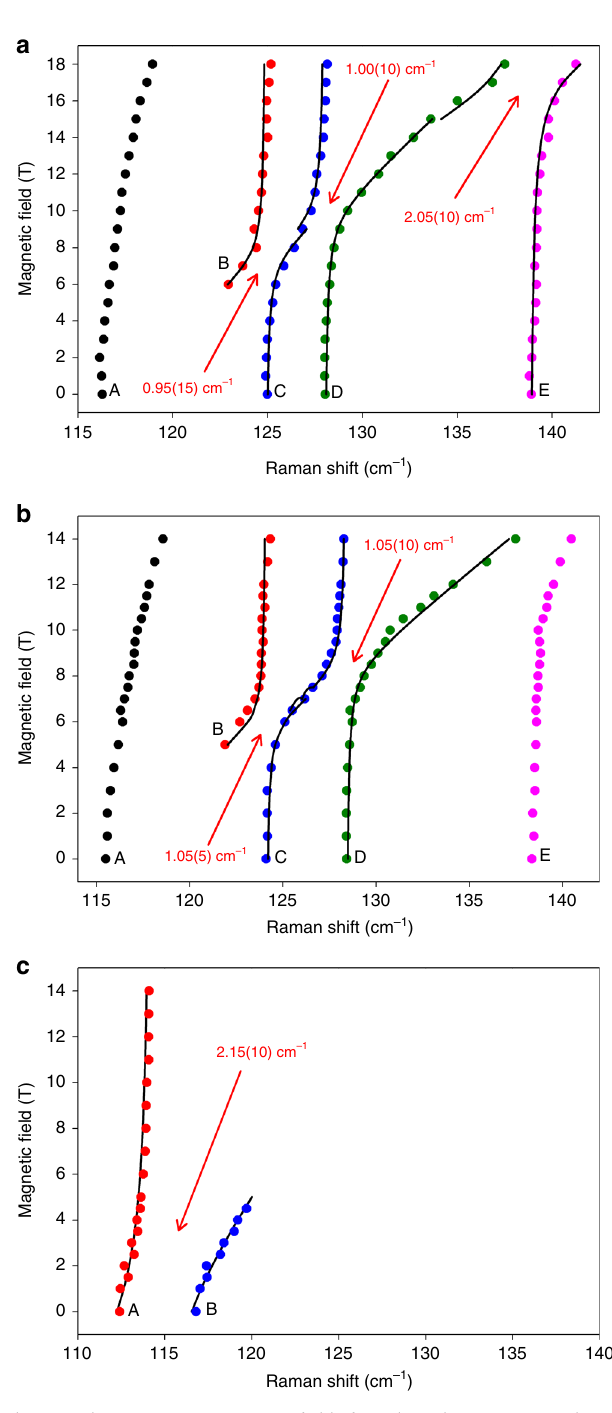
Fig. 7b) with the fi eld in the x -direction (second possible transition above), the ϕ 1 |0 〉 → ϕ 3 |0 〉 transition in the x -direction (red line II in Fig. 7b) to the left of trace 1 in Fig. 6b is expected. Such behavior can be explained by the difference in the effective g values, Δ g' = 2.65 − 2.34 = 0.31, which is still positive. In fact, traces 1 and 2 in Fig. 6b are consistent with the analysis. Starting